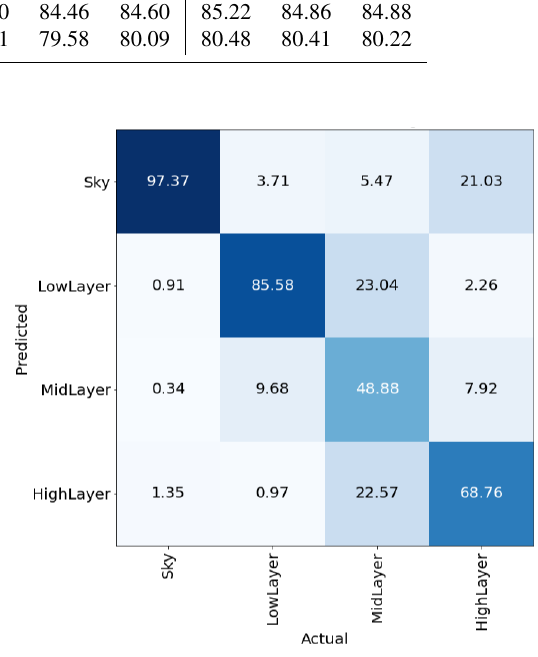
Figure 6. Confusion matrix of segmentation model with IP–SR*